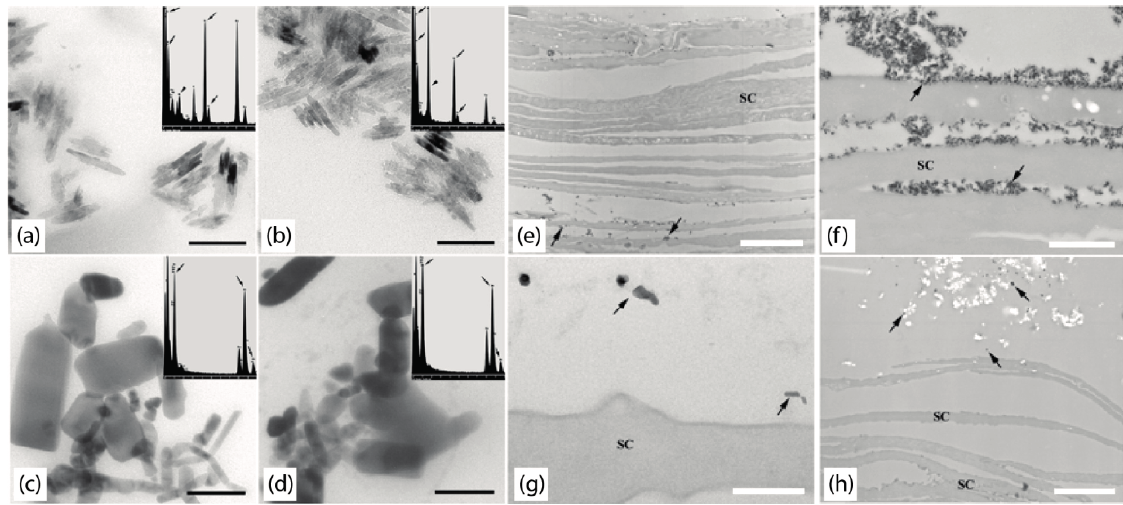
Figure 1. Transmission election micrographs of various diluted TiO 2 -nanoparticles (NP) in ultrapure water and in porcine skin: ( a ) CM 630, 10% TiO 2 (T-Lite SF); ( b ) CM 634, 10% TiO 2 (T-Lite SF); ( c ) CM 643, 5% ZnO (Z-COTE HP1); ( d ) CM 644, 5% ZnO (Z-COTE). TEM images of stratum corneum are shown of ( e ) CM 630 treated, UVB-exposed skin; ( f ) high magnification of CM 634 treated, UVB-exposed skin; ( g ) CM 643 treated, UVB-exposed skin; ( h ) CM 644 treated, UVB-exposed skin. The black bars represent 100 nm. The white bars in ( e , h ), ( f ) and ( g ) are 4 µm, 1 µm and 250 nm,